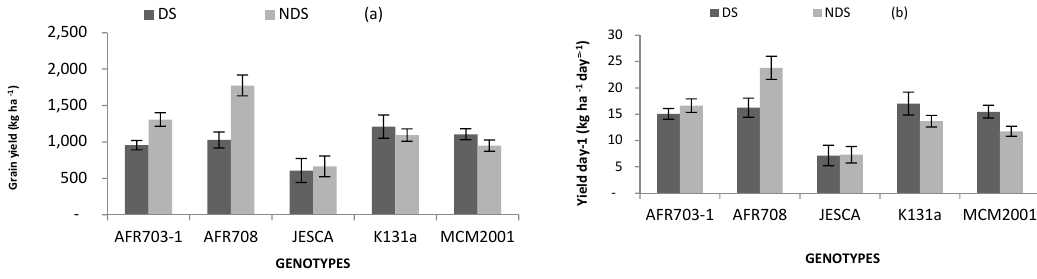
Figure 4. Interaction between genotypes and drought conditions on ( a ) grain yield; ( b ) yield day − 1 (bars over the mean indicate standard error). DS: drought stress, and NDS: non-drought stress.